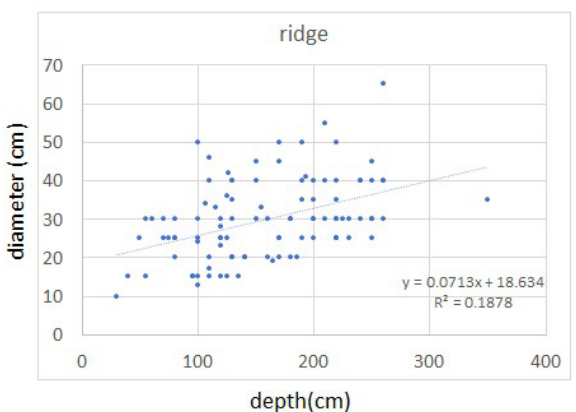
Figure 11 . Relationship between diameter and depth of roots in ridge